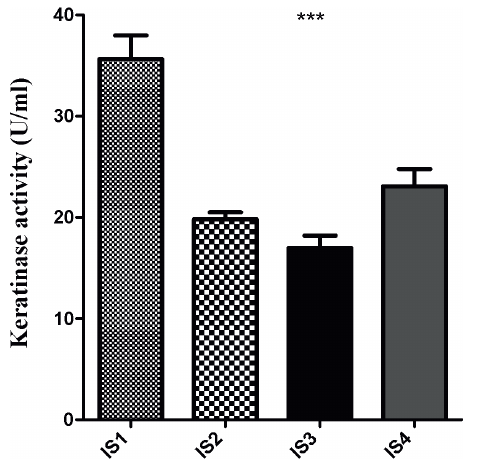
Figure 4. Observation of Keratinase activity of the isolates. Graphical representation showing the amount of keratinase activity by the microorganisms. Y-axis indicates the enzymatic activity expressed in U/ml and X-axis denotes the test isolates. Data (n = 3) illustrated in the bar diagram as mean +SD.